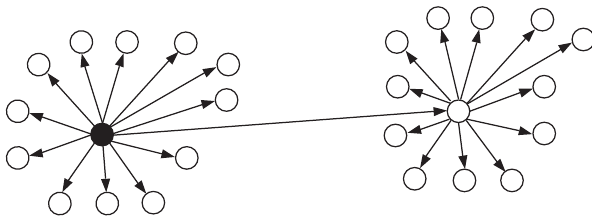
Figure 3: Schematic of marketing information diffusion. Note: the black solid node is the current initial publisher of marketing in- formation, the hollow nodes are the other users, and the arrow represents the direction of information flow.